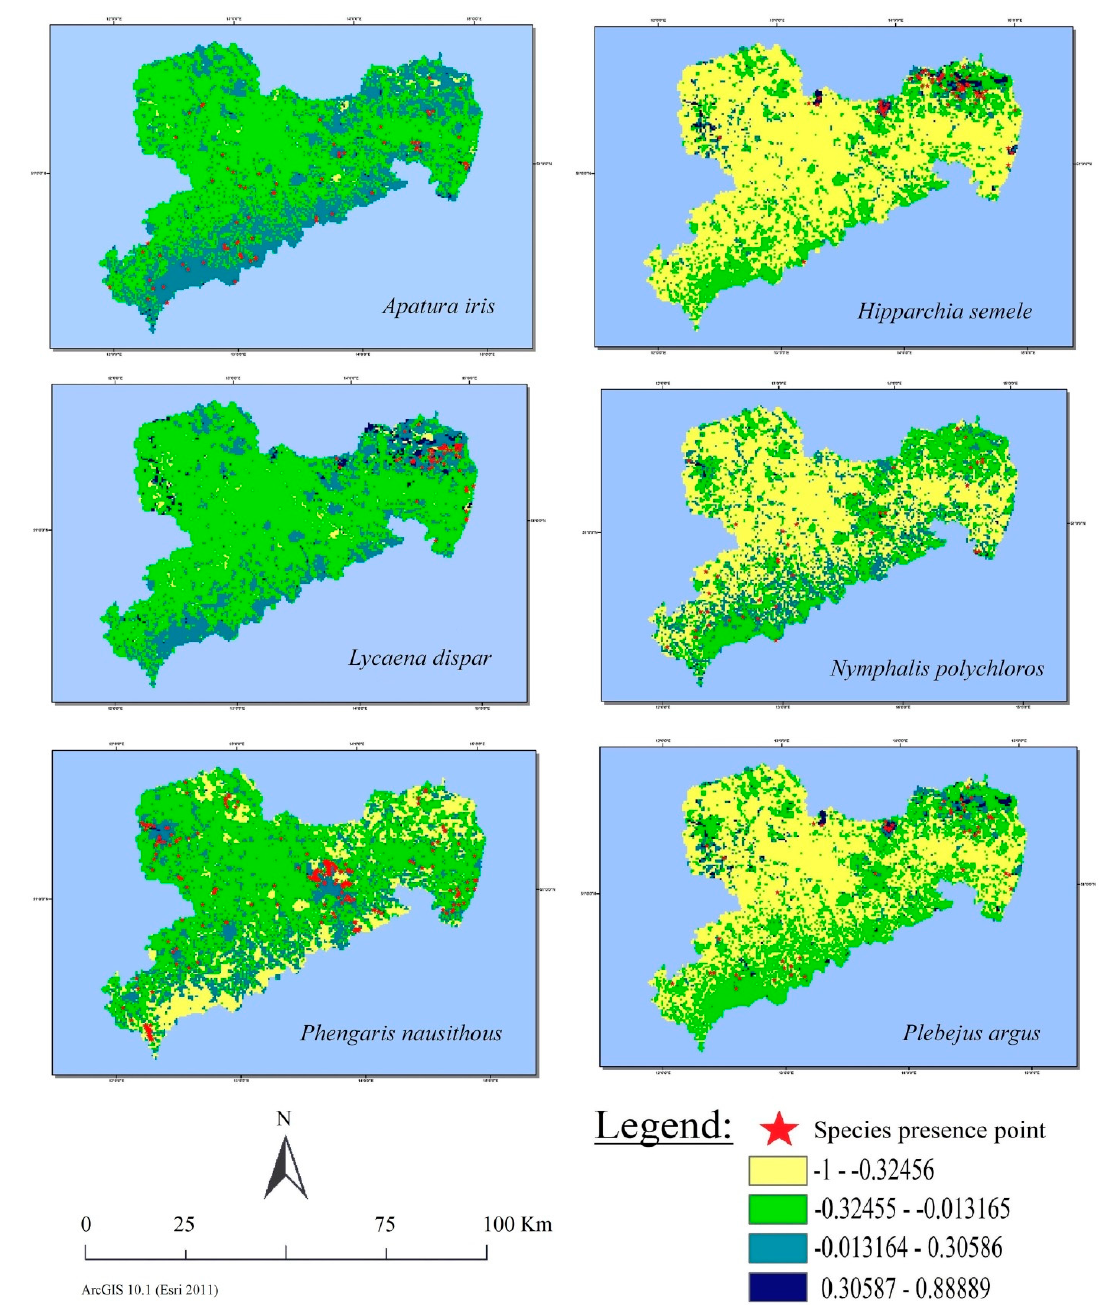
Figure 3. Maps of habitat preference based on IEI abund for all six species (IEI values towards − 1.0 indicate avoidance while +1.0 represents suitable).